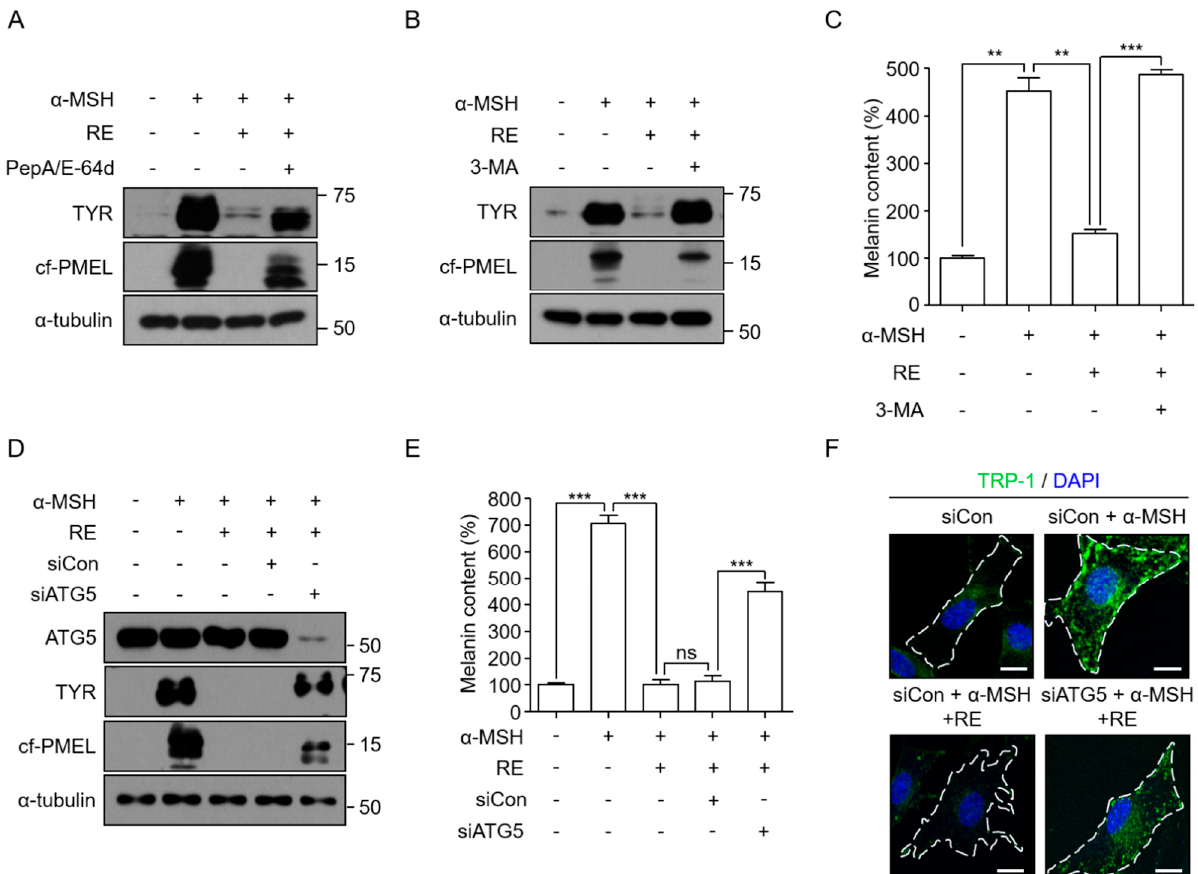
Figure 2. Depigmentation effect of A. fruticosa RE depends on autophagy-mediated melanosome degradation. ( A ) B16F10 cells were treated with 1 μ M α -MSH in the presence or absence of 3.12 ppm of A. fruticosa RE for 24 h. Cells were further treated with PepA/E-64d (10 μ g/mL each) for an additional 24 h. The indicated protein expression levels were analyzed using Western blotting. ( B , C ) Following treatment of B16F10 cells for 48 h with 3.12 ppm of A. fruticosa RE in the presence or absence of 800 μ M 3-MA, the indicated protein levels ( B ) and melanin content ( C ) were analyzed.